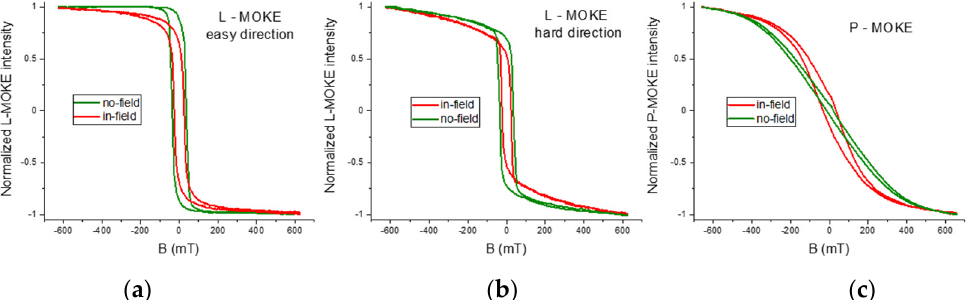
Figure 5. MOKE hysteresis loops measured for the 10 nm Fe 3 O 4 (111) films deposited with an in- plane magnetic field applied along the 110 direction and with no field (red and green curves, respectively). ( a , b ) L-MOKE loops with the magnetic field applied along in-plane easy and hard directions, respectively; ( c ) P-MOKE loops.